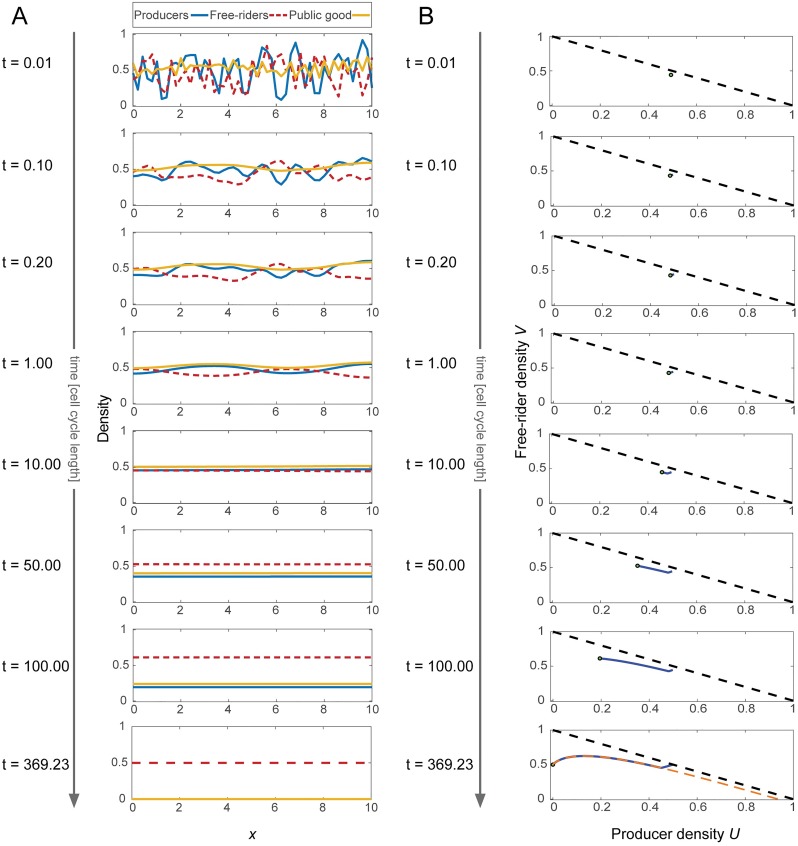
Typical 1D simulation leading to producer extinction.A: Snapshots of the system, represented by concentration of producer cells (U), free-riders (V) and growth factor (G) over time, measured in cell-cycle length (time advances top to bottom). The population game is played in 1D, the panels show the concentrations in space. B: Corresponding trajectory of the average number of producers and free-rider densities in their phase space (U = V on the black dashed line). Due to cell motility, the system reaches the slow manifold (orange-dashed line in bottom panel) fast, and spends most of the time traveling along the slow manifold. The slow manifold was calculated numerically from the well-mixed, ODE model. Dimensionless parameters used: γU = γV = 0.5, a = 0.9, c = 0.5, r = 1, ϵ = 2 × 10−3, β = 5, σ = 2.